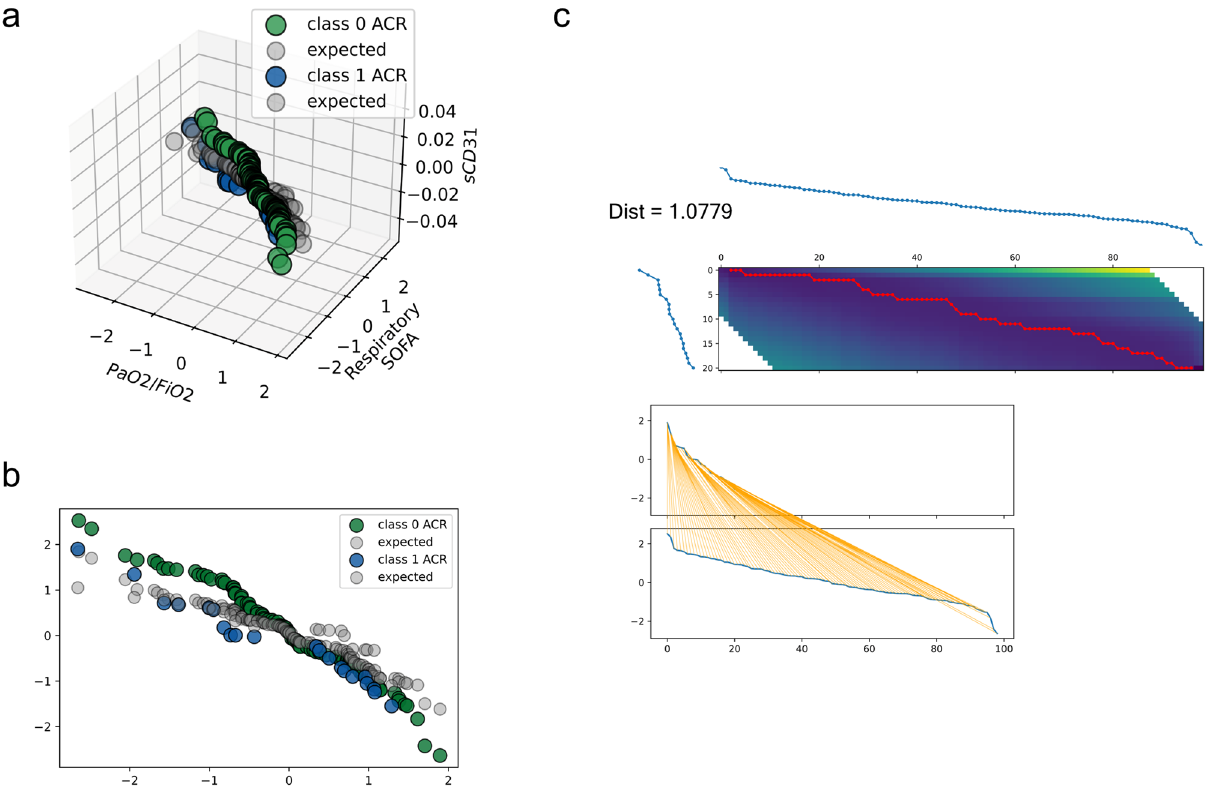
Figure 1. Remarkably higher sCD31 concentration in patients who experienced ACR after LT. A relative concentration of sCD31 to ACR might be observed in ( a ). Whether or not the patients experienced any complication was highlighted in green or blue in the curves. The expected value predicted by our VAR model is shown in grey. A 2D projection of ( a ) is shown in panel ( b ). The grade of separation in sCD31 concentration between patients with or without complications after LT was calculated using 2d-DTW (see “Methods”) in upper panel ( c ). The distance function has linear space complexity but quadratic time complexity. Panel c displays the matrix with all possible warping paths (i.e., accumulated cost matrix) that resulted in a perfect match between indices of ACR time